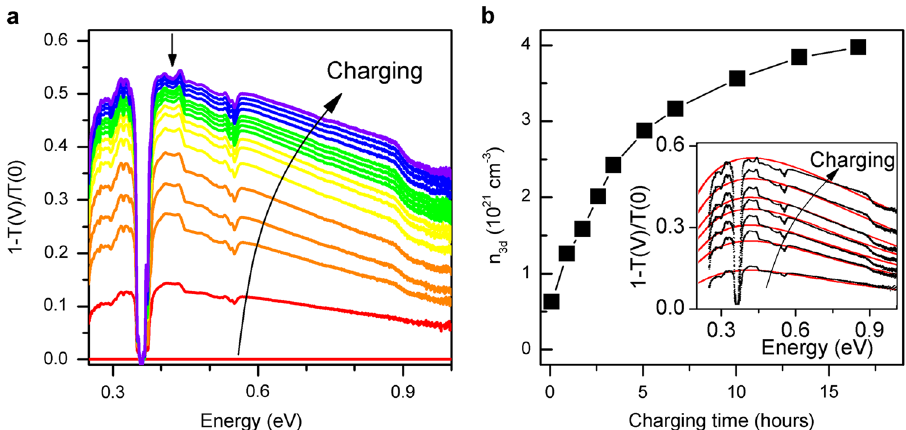
Fig. 6 Fourier transform infrared spectroscopy (FTIR) data and fi tting results. a , Infrared absorption spectrum obtained from FTIR measurement during the charging process of a 45 nm WO 3 fi lm. The electrolyte is DEME-TFSI and the charging was done at room temperature (294 K). At this temperature, 1.5 V is a gate voltage that we can safely apply according to our previous experience. The time interval between each curve is about 1 h. The cut-off at 0.2 eV is due to a glass window that we used to hold the ionic liquid. If no gate voltage is applied, the total drift of the absorption spectra in 20 h is below 0.05, i.e., 10 times smaller than the change due to electrolyte gating. The short vertical arrow indicates the position of the broad IR peaks (taking up the entire spectral range shown) that corresponds to the polaron binding energy. b , 3D carrier concentrations as a function of charging time calculated from the fi tting results. (Inset) Solid lines are the fi tting results using the Lorentz oscillator model (see